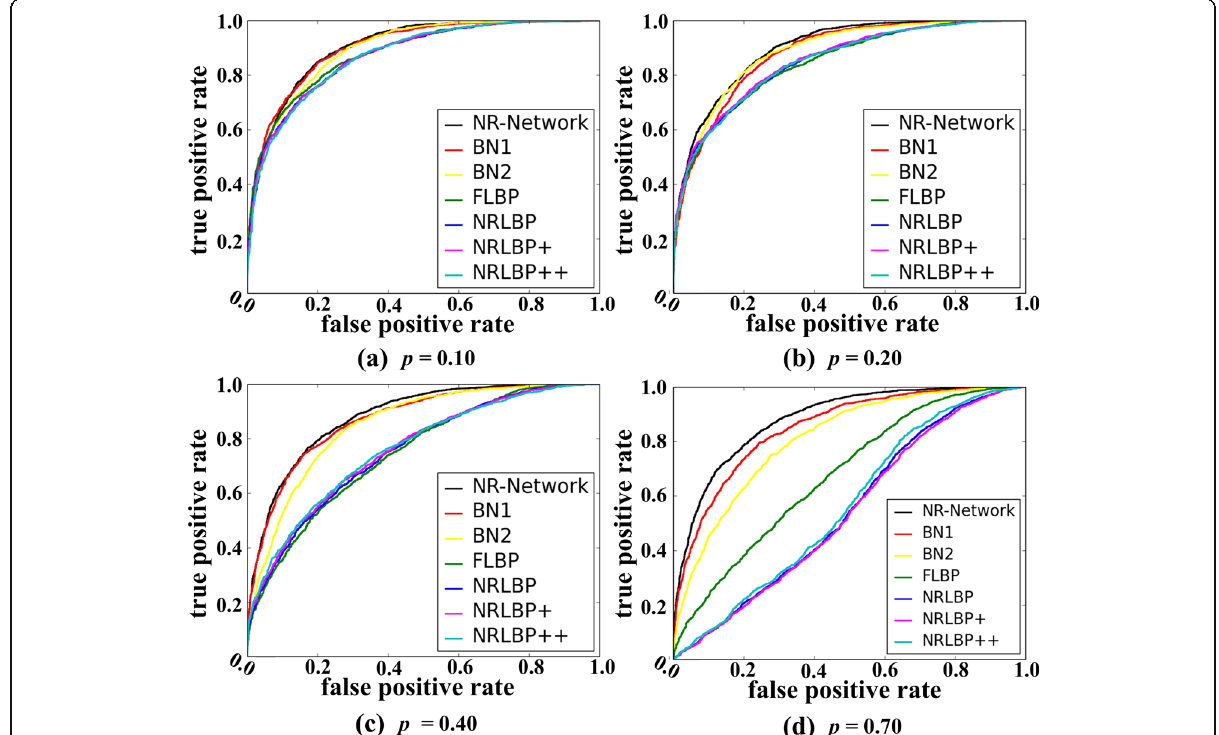
Fig. 6 The ROC curves on the AR database with uniform noise p =0.10, 0.20, 0.40, 0.70. Black line the NR-Network method, red line the BN1 method, yellow line the BN2 method, green line the FLBP method, blue line the NRLBP method, carmine line the NRLBP+ method, cyan line the NRLBP++